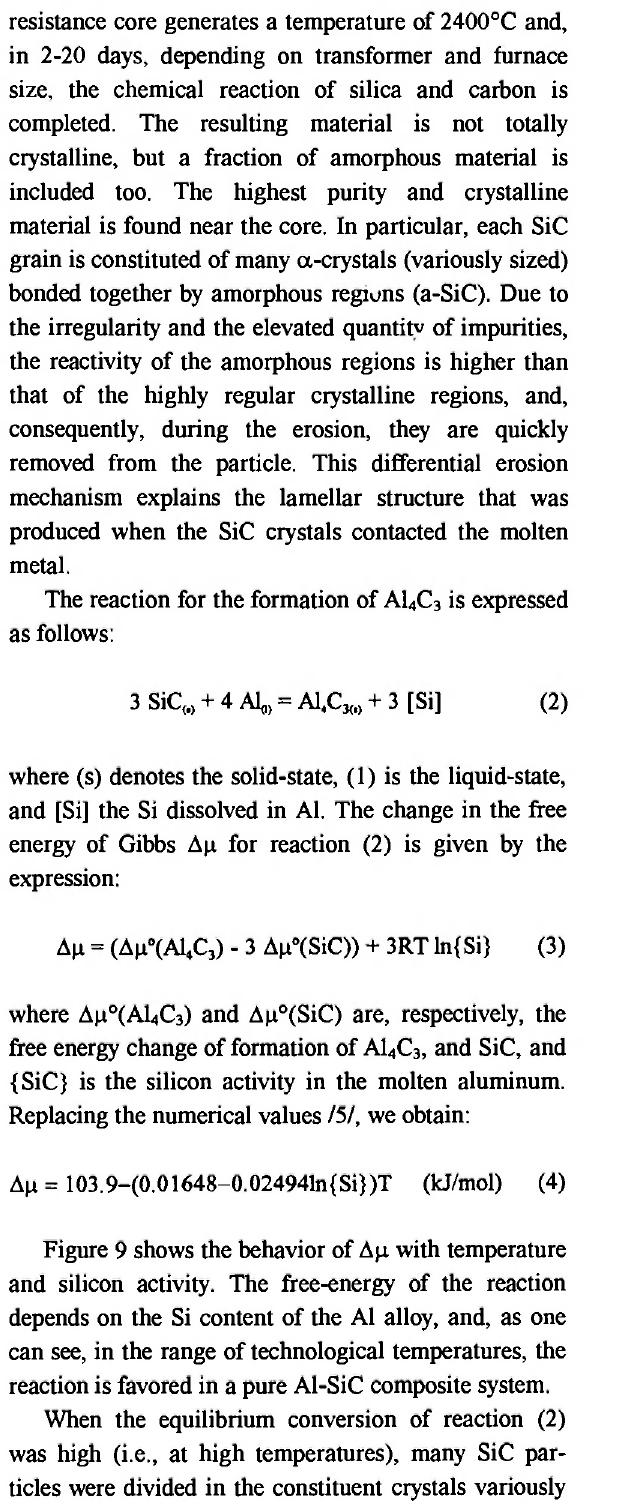
Fig. 8: SEM-micrograph showing the full disintegration of the grains after a very long remelting treatment (48h at